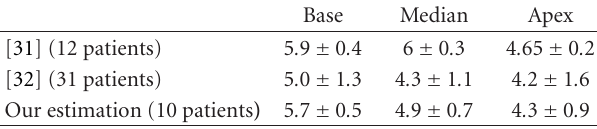
Table 2: Comparison between our quantification and two studies of the medical literature concerning the estimation of the radial displacements (expressed in millimeters) for healthy